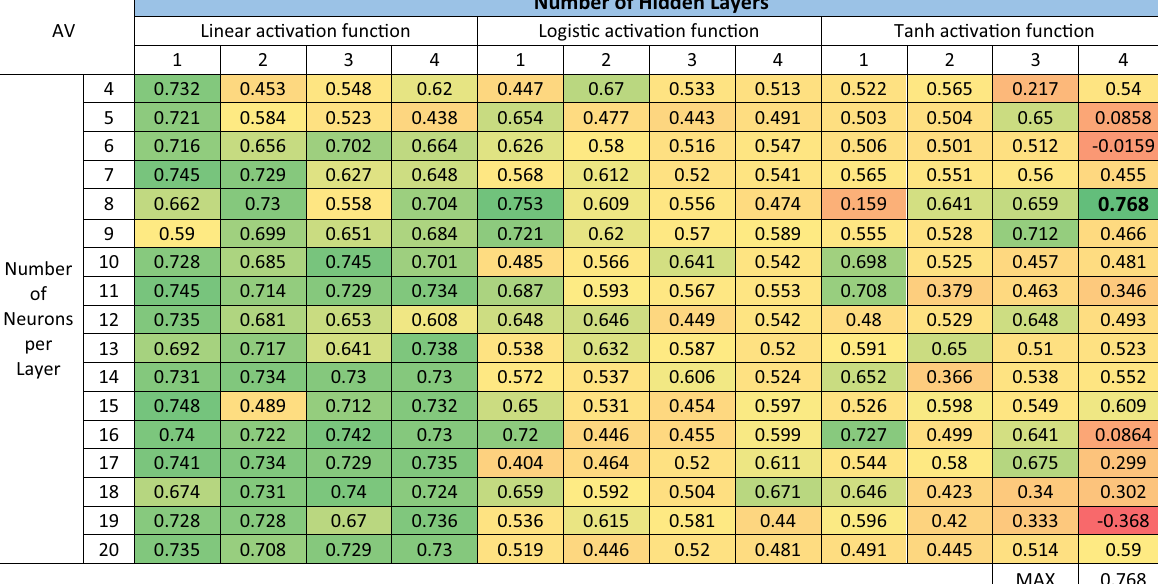
Number of Hidden Layers